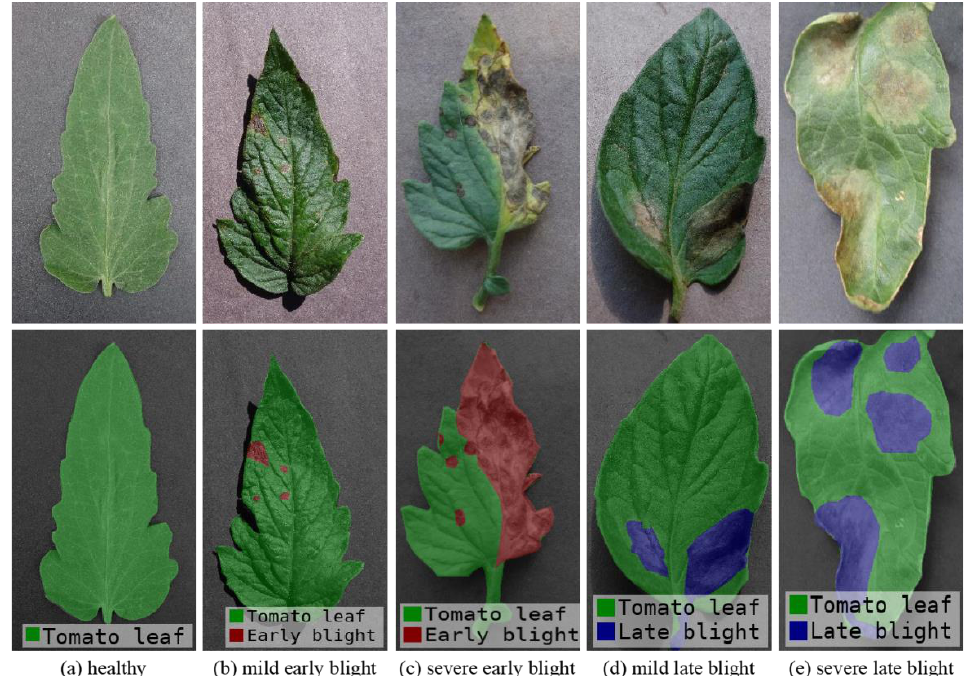
Figure 1. TDSD labeling examples, green is the leaf, red is the early blight spot, and blue is the late blight spot.